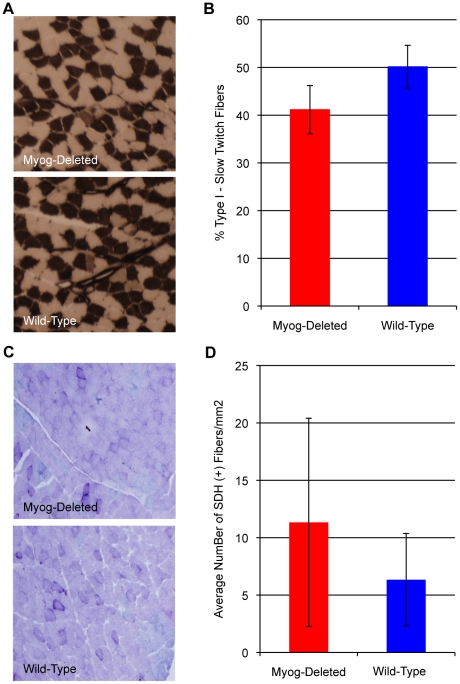
Fiber type proportion and oxidative activity in untrained wild-type and Myog-deleted mice.(A, B) Fiber type proportion. Myog-deleted mice had normal proportions of type I and type II fibers in soleus muscle. Myosin ATPase staining was used to identify type I and type II fibers in the soleus muscle (A). Average quantified values revealed normal proportions of fiber types (B). Blue bar indicates wild-type control values; red bar indicates Myog-deleted values. Error bars represent one standard deviation. (C, D) Oxidative activity. Myog-deleted mice had no difference in SDH activity in gastrocnemius. SDH staining was used to identify oxidative fibers in the medial gastrocnemius (C). Average quantified values revealed normal oxidative activity (D). Blue bar indicates wild-type control values; red bar indicates Myog-deleted values. Myog-deleted, n = 3; wild-type, n = 3. Values for each mouse were averaged from the analyses of two 1 mm2 fields. Error bars represent one standard deviation.